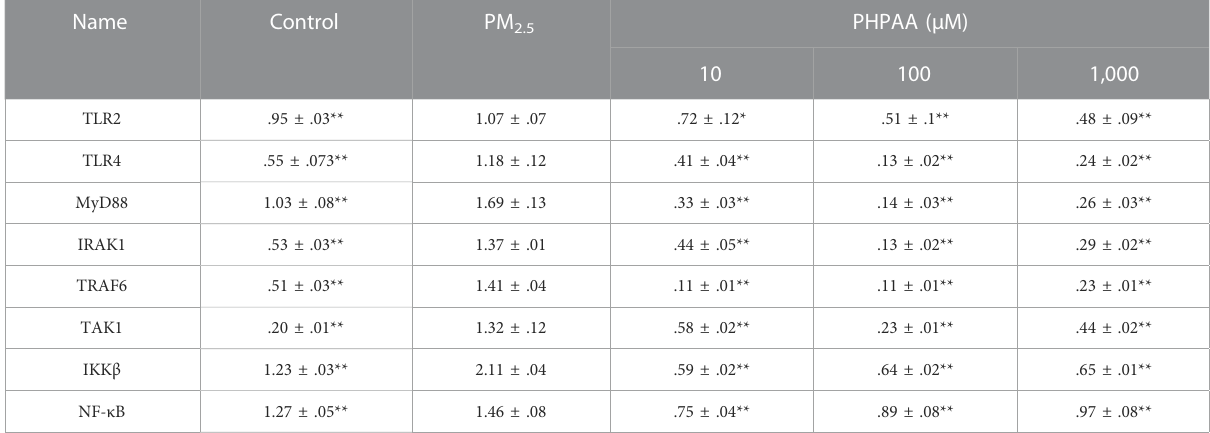
TABLE 3 Effects of PHPAA on gene expression in TLRs related pathways. Name